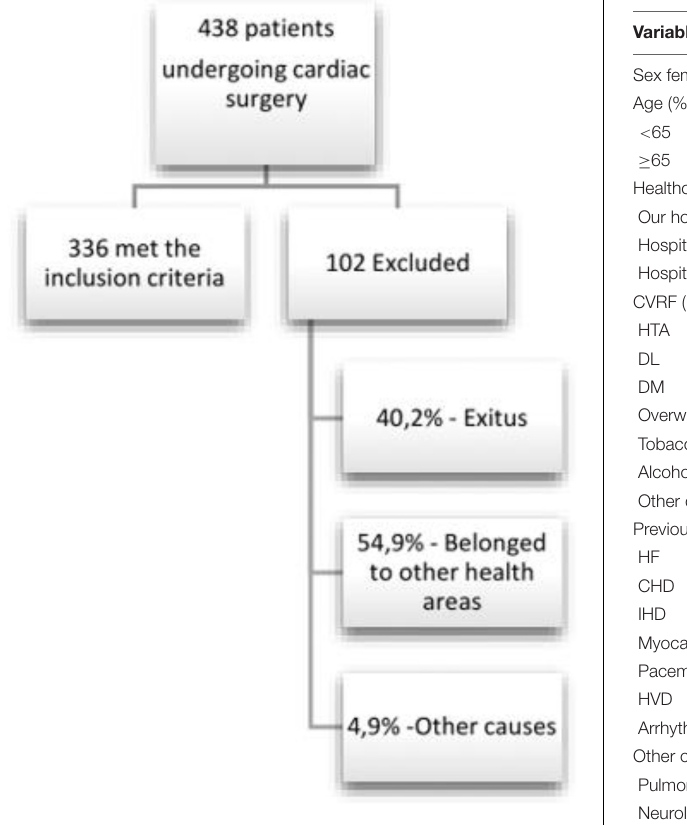
TABLE 1 | Sociodemographic and clinical data of the total